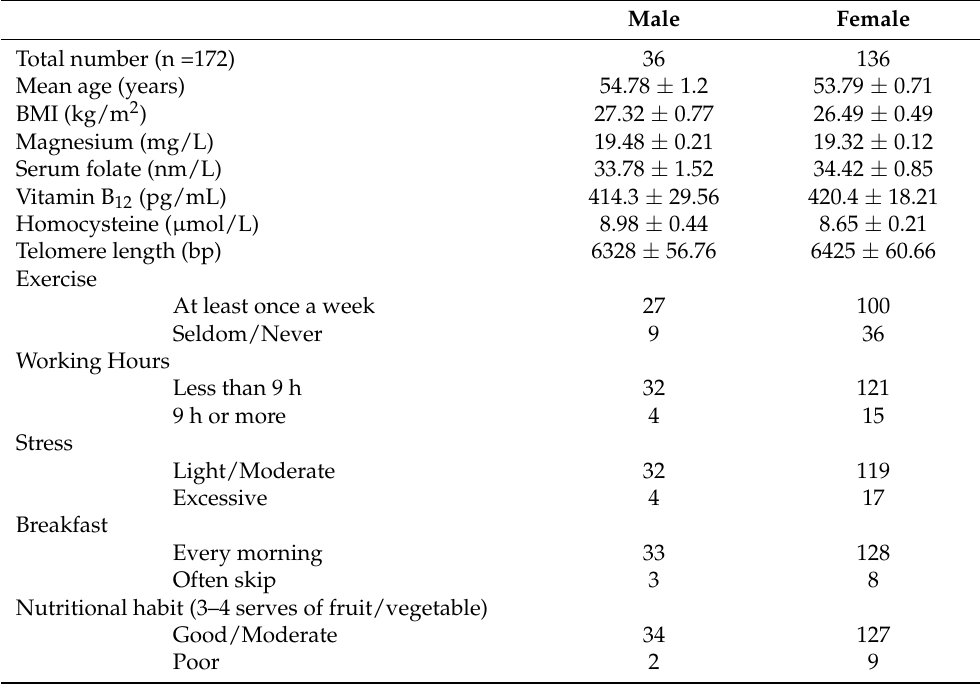
Table 1. Baseline characteristics of the study